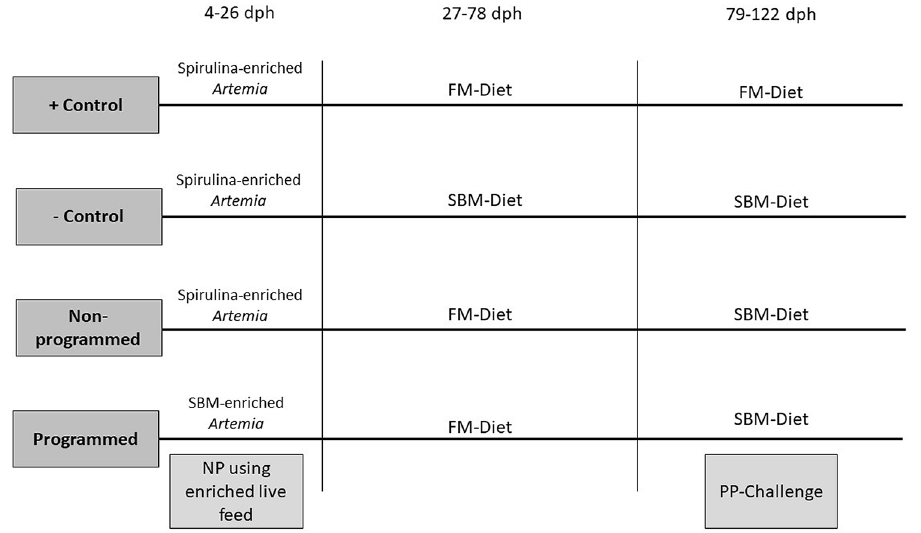
Figure 1. Feeding regime for each experimental group. Dph days post hatch, FM fishmeal, PP plant protein, SBM soybean meal, NP nutritional